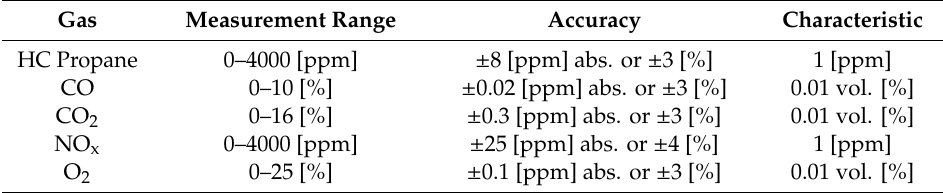
Table 4. Characteristics of Axion RS, a portable exhaust emissions analyzer